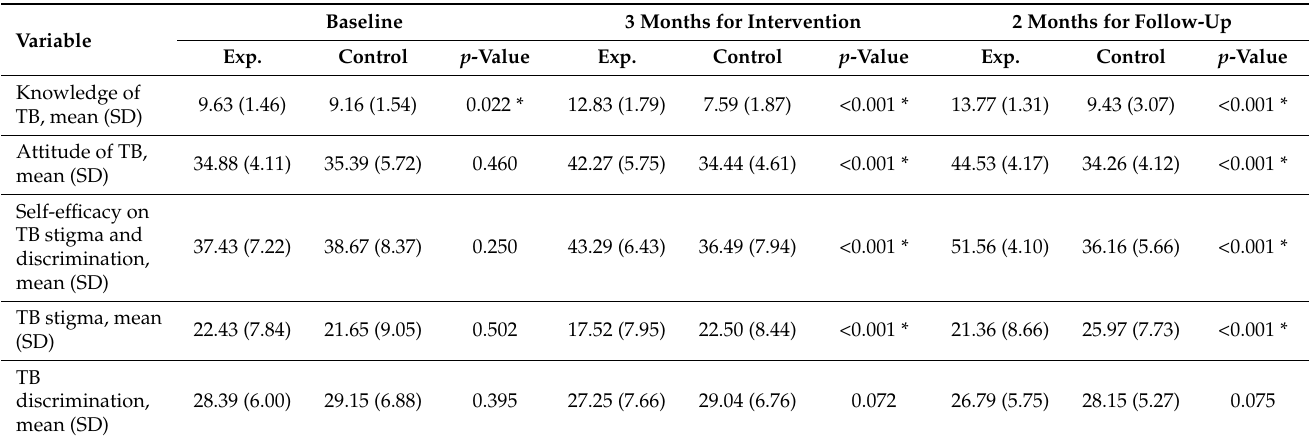
Table 2. Between-group comparisons of knowledge of TB, attitude of TB, self-efficacy on TB stigma and discrimination, TB stigma and TB discrimination at baseline, month 3 and month